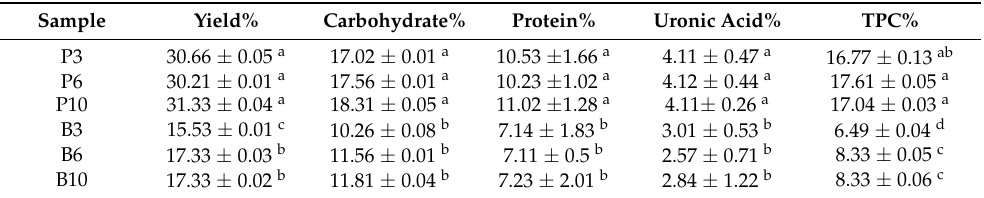
Table 1. Major chemical content of the crude polysaccharide extracts from chaga sclerotia. The data represent the mean ± SD of triplicate experiments.